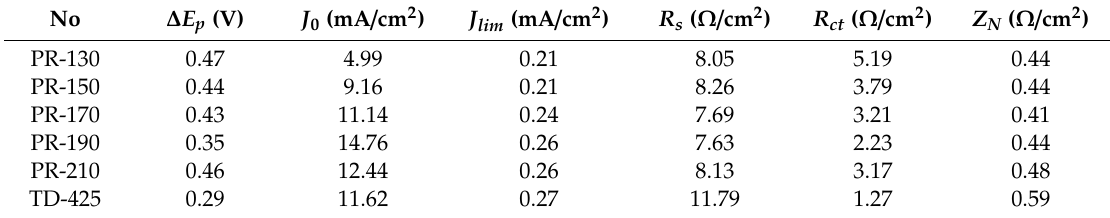
Table 2. Electrochemical parameters of polyol-reduction Pt films at di ff erent reaction